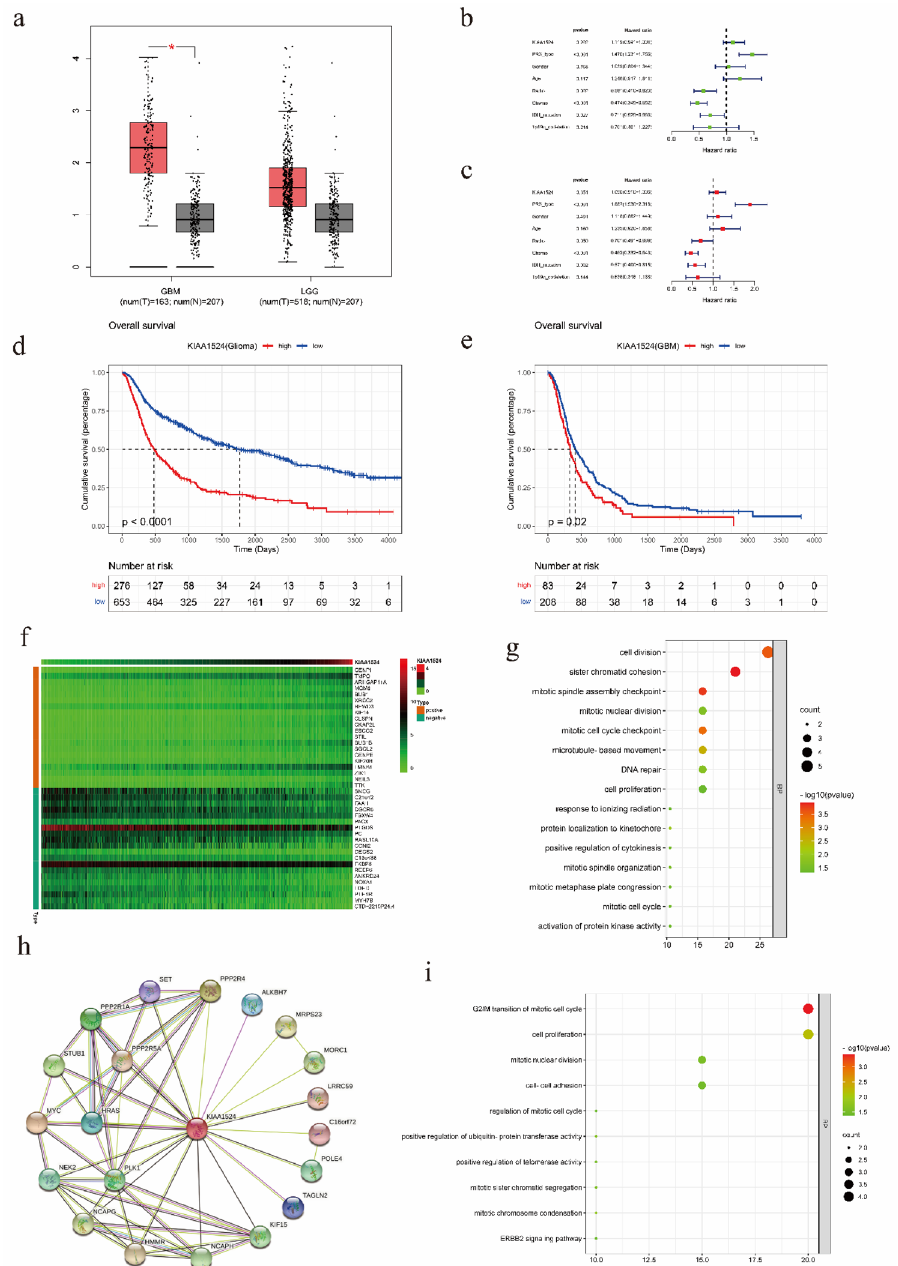
Figure 4. Bioinformatics analysis of KIAA1524 ( a ) The mRNA level of KIAA1524 was analyzed by Gene Expression Profiling Interactive Analysis (GEPIA). ( b , c ) Univariate and multivariate Cox analyses of KIAA1524 expression and other clinical pathological factors. ( d , e ) Survival curve of differential KIAA1524 expression. ( f ) Heatmap of top20 KIAA1524 associated genes in glioma. ( g ) GO analysis of top20 KIAA1524 positively related genes in glioma. ( h ) Protein interaction of KIAA1524. ( i ) GO analysis of KIAA1524 interacting